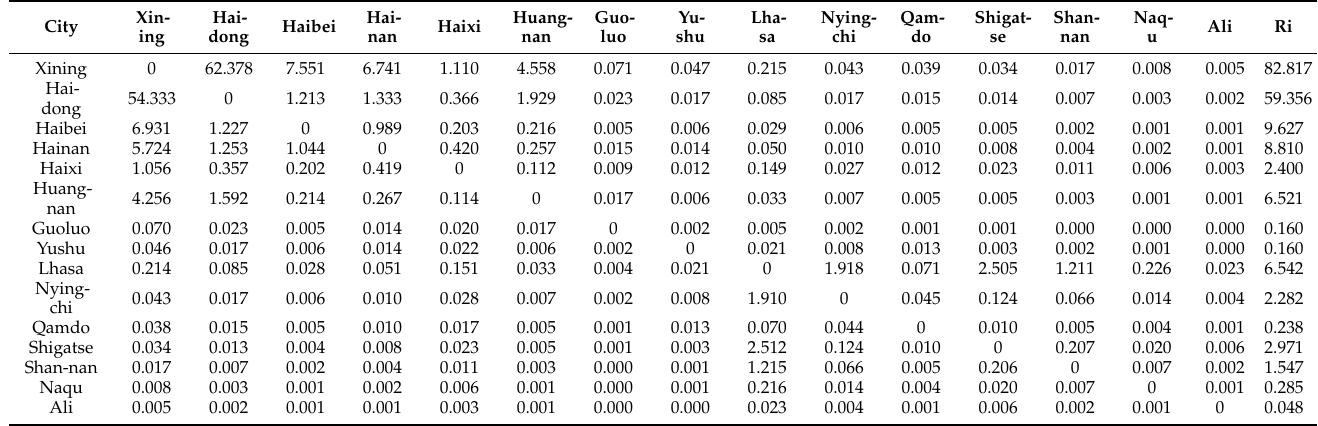
Table 2. Intensity of tourism economic